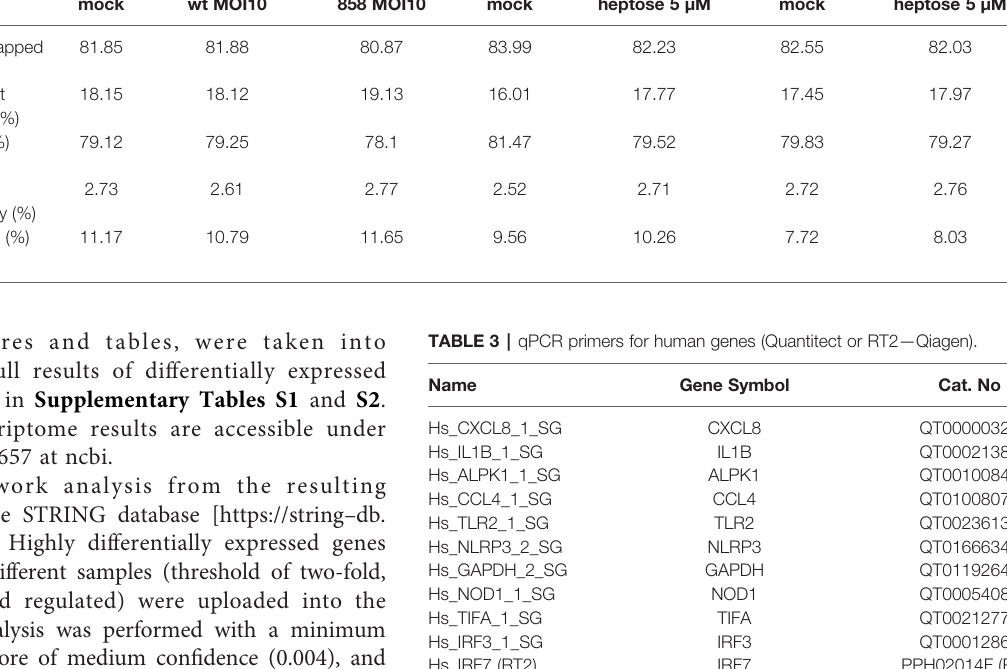
TABLE 2 | Quality control parameters of comprehensive transcriptome sequencing (RNA-Seq).